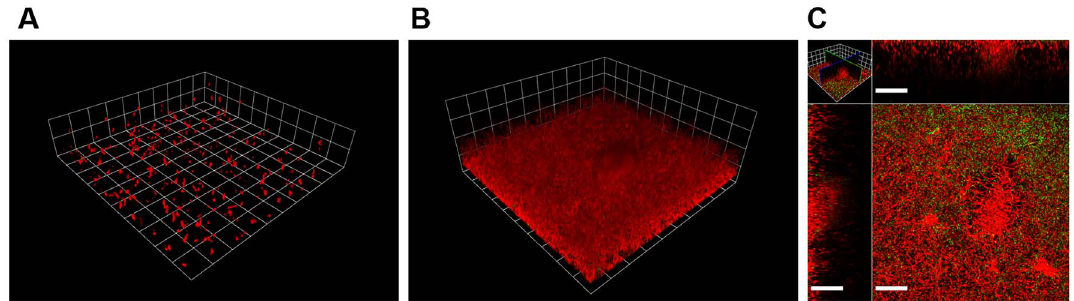
Figure 8. Colonization of indole-deficient E.coli JW3686 biofilms by P.aeruginosa in R2A medium. E. coli appears red and P. aeruginosa - GFP appears green or yellow. A) Mono-cultured, 3-day old E. coli formed sparse biofilms composed of small, isolated cell clusters (grid unit is 23.8 m m). B) Mixed P. aeruginosa and E. coli biofilm on day 6, after 3 days of mono-species E. coli growth plus 3 additional days of multi-species growth after inoculation of P. aeruginosa . (grid unit in B is 23.8 m m). Following introduction of P. aeruginosa , E. coli grew extensively and adopted a configuration similar to that observed in other mixed-species experiments. C) Horizontal section near the base of the biofilm and vertical sections of the biofilm shown in panel B (scale bar=40 m m).